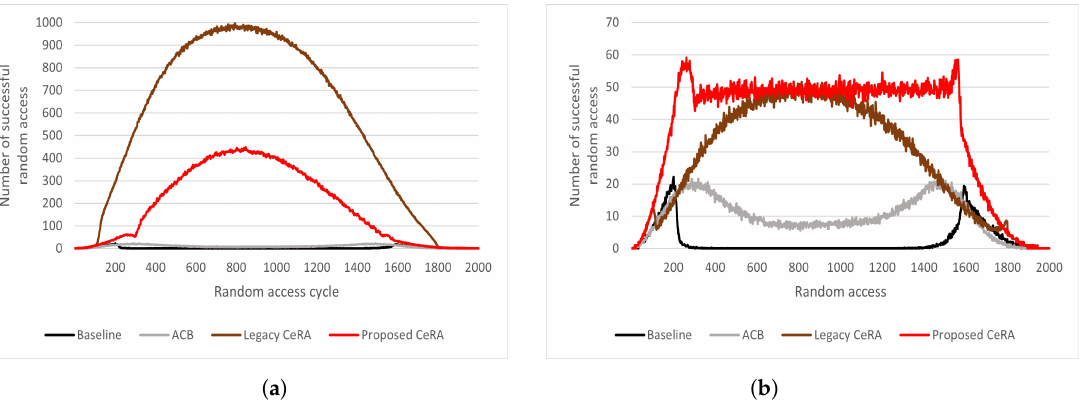
Figure 8. ( a ) NumberofSuccessfulpreambletransmissionsand ( b )